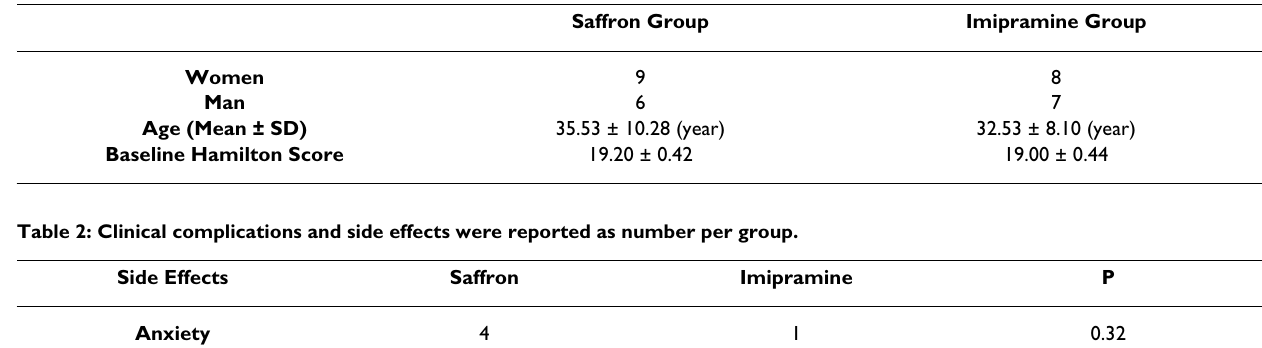
Table 1: Baseline data